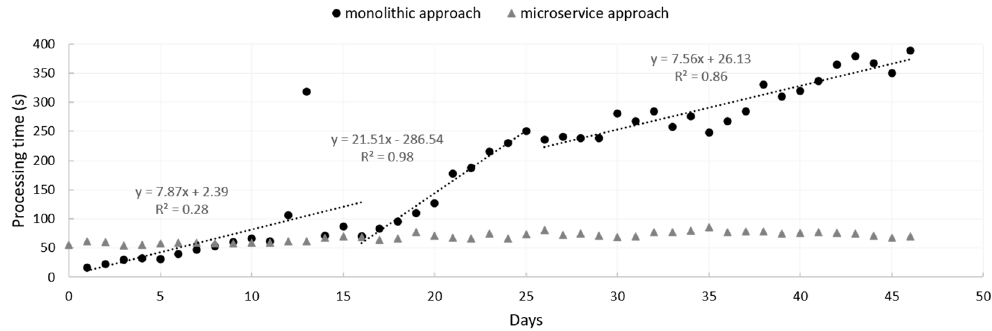
Figure 9. The latency of the ASS "crop parameter" microservice in a rice farm when designed to perform individually for each farm (microservice-based approach) and as a monolithic service.